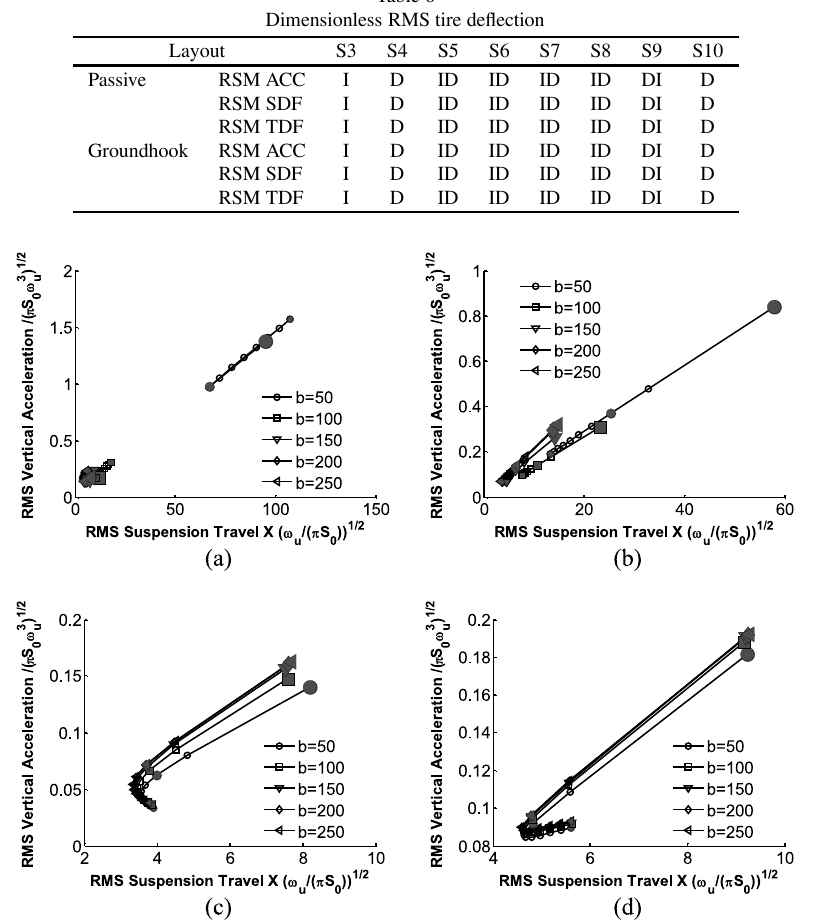
Table 6 Dimensionless RMS tire de fl ection